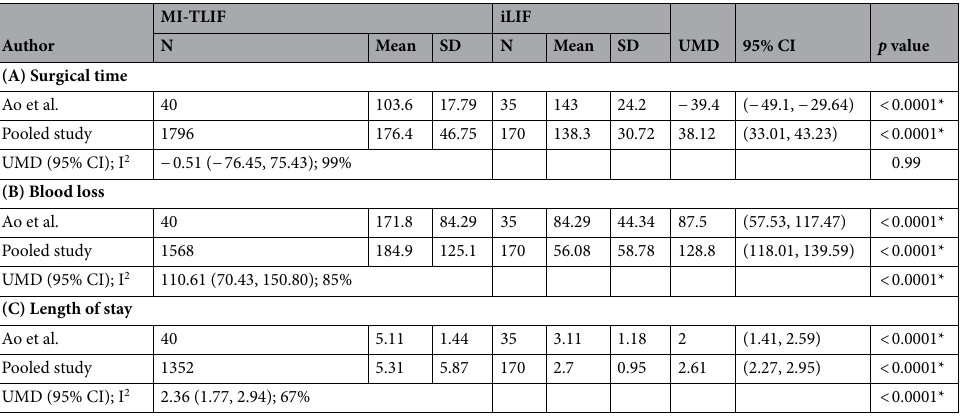
Table 4. Unstandardized mean differences surgical time, blood loss and length of stay between MI-TLIF and iLIF. Significant values are in